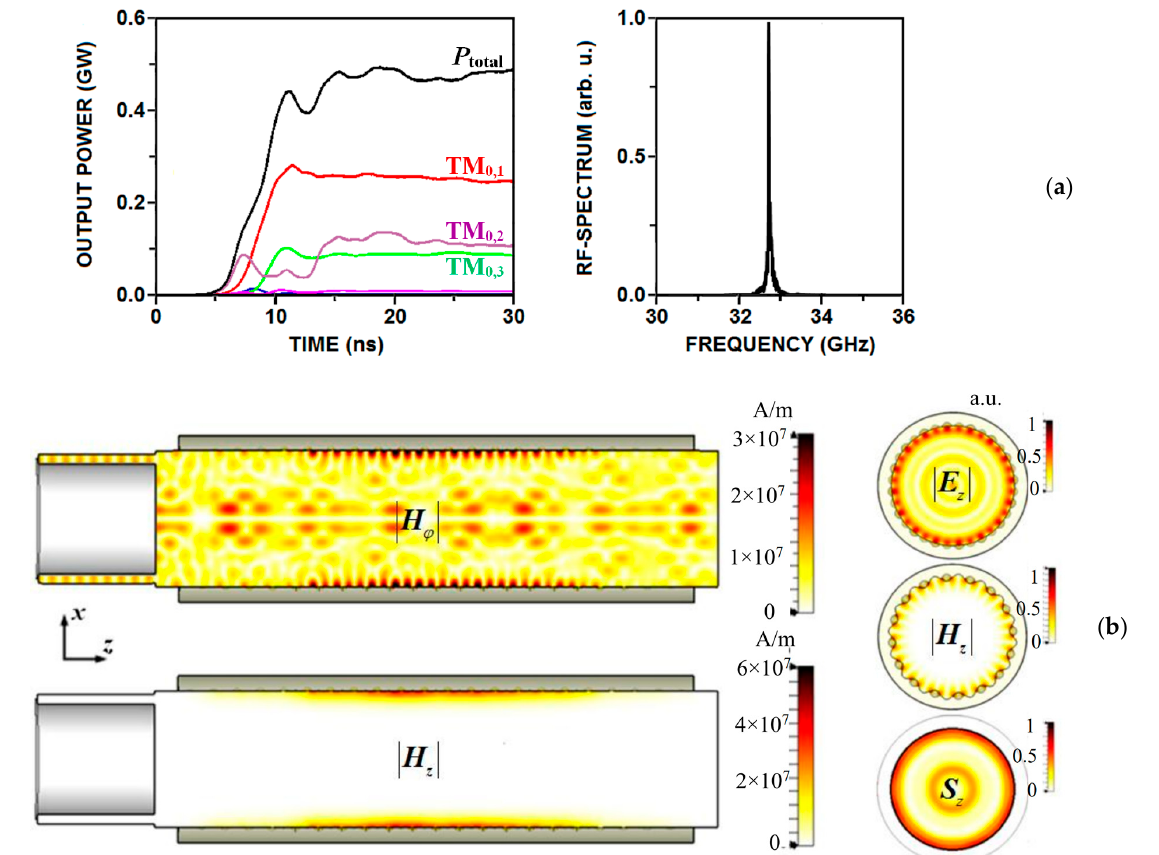
Figure 12. Results of the 3D PIC simulations of Ka-band 2D SWO based on the “Sinus-6” accelerator (code CST Studio Suite). ( a ) Time dependence of the total output power and partial powers associated with different waveguide modes ( left ) and radiation spectrum in the steady-state generation regime ( right ) as well as ( b ) spatial instantaneous structure of the RF-field: H φ and H z components in the longitudinal cross-section ( left ) and E z and H z components in the transverse cross-section inside the interaction space and axial component of the Poynting vector S z of the output radiation ( right ).